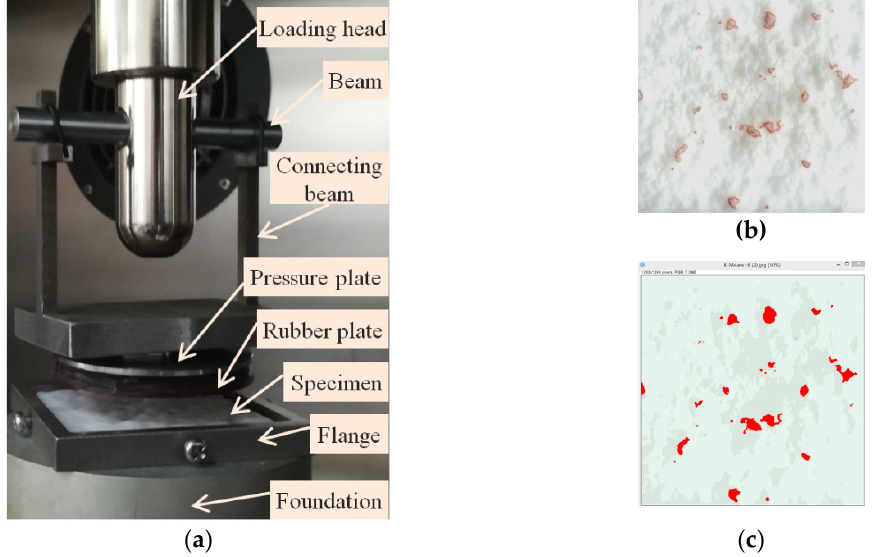
Figure 3. Measurement of the contact area. ( a ) self-designed fixture ( b ) the dyed area on the specimens’ surface, ( c ) the identified contact area.